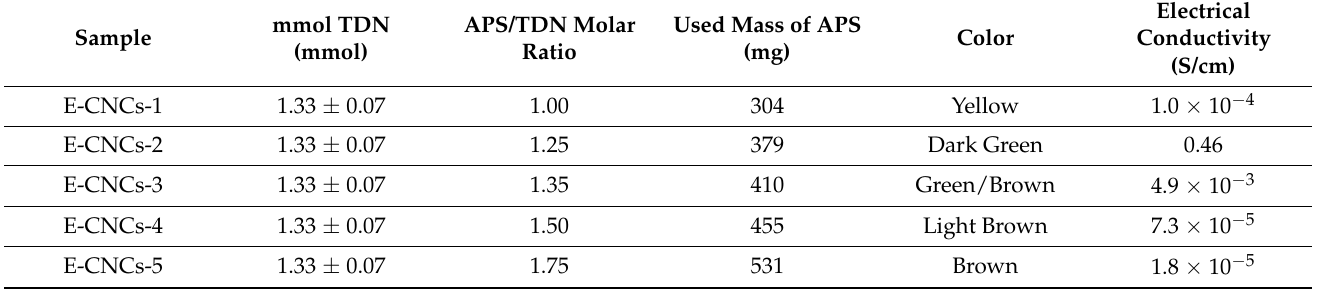
Table 2. The color and electrical conductivity of the E-CNCs after polymerization using different amounts of APS.